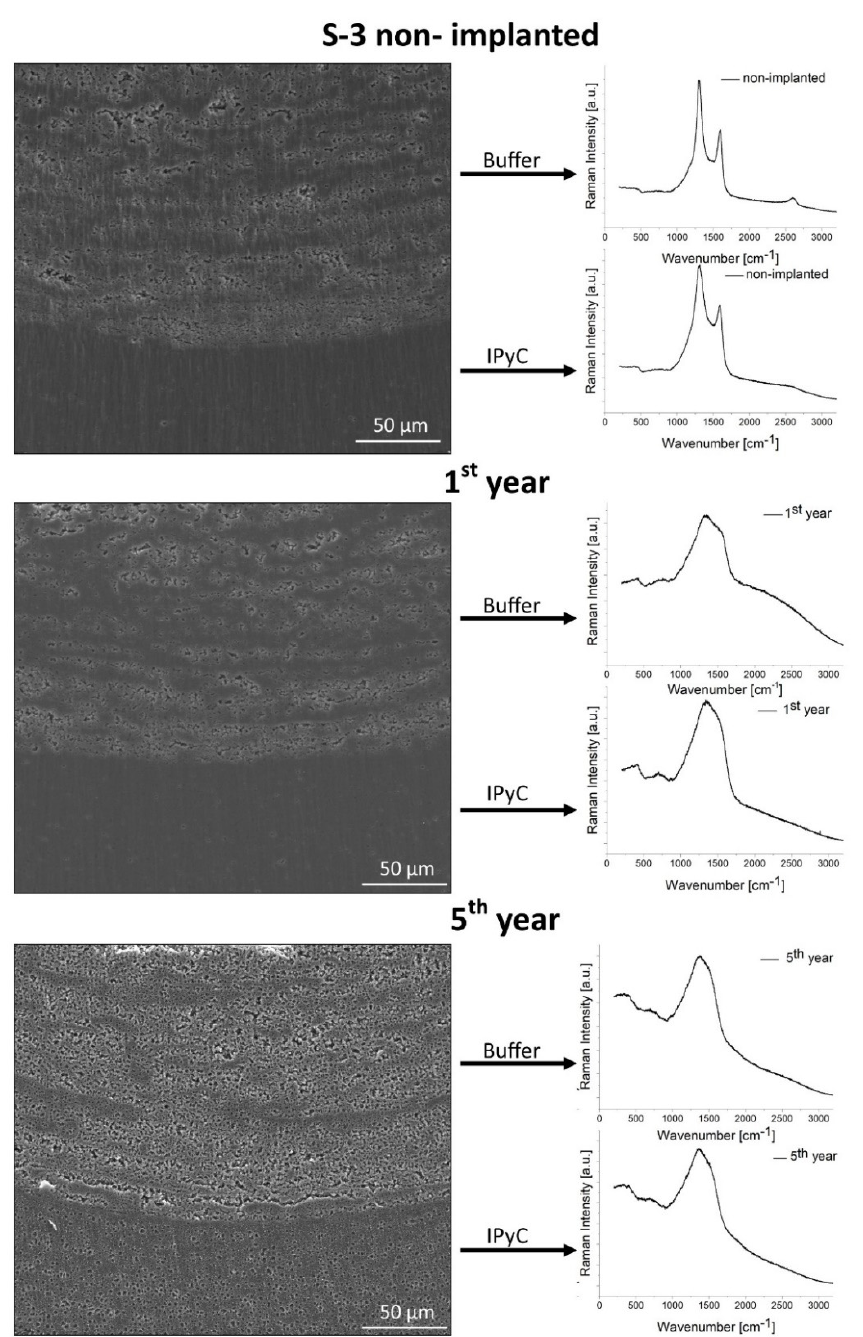
Figure 3. On the left-hand side—SEM image of the p-TRISO sample covering layers (Buffer, IPyC) before and after ion implantation; on the right-hand side—Raman spectra obtained for each of the analyzed layers after the ion implantation process.